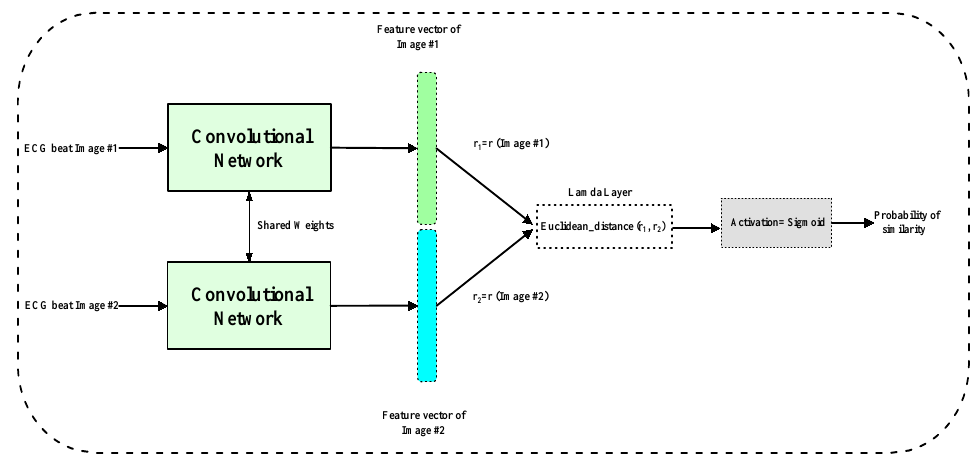
Figure 4. Block diagram of the proposed biometric authentication system during the training phase.